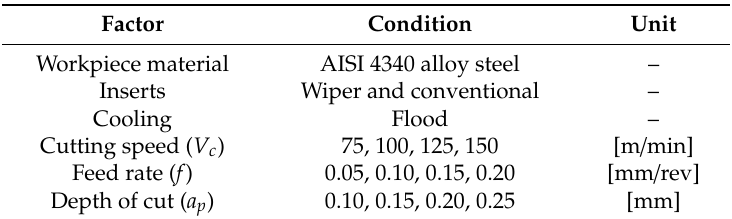
Table 2. Cutting